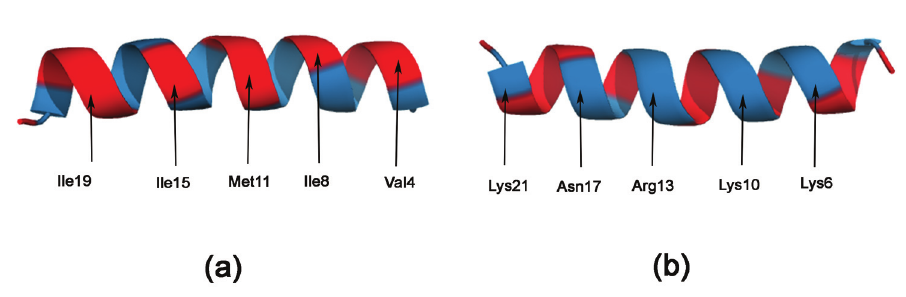
Figure 4. Pymol rendering of peptides showing the hydrophobic and charged surfaces for the N-terminal helix of cecropin B. All hydrophobic residues are colored in red, while hydrophilic residues are colored in blue.